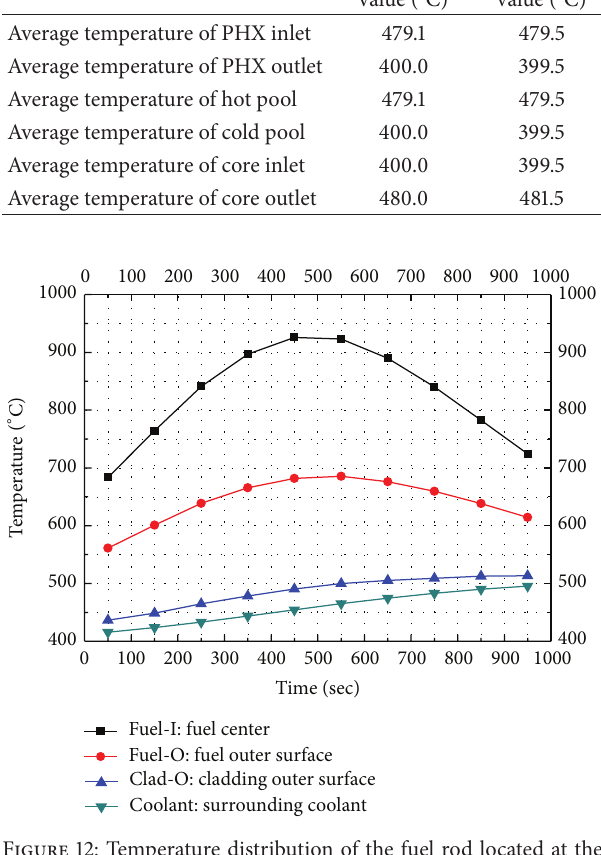
Figure 12: Temperature distribution of the fuel rod located at the core hottest fuel assembly.